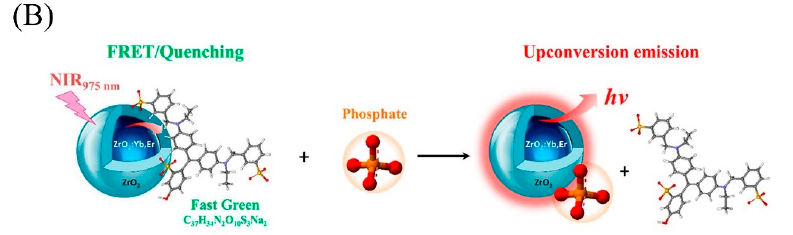
Figure 5. UCNPs for detecting heavy metal, inorganic acid ion and air pollutants. ( A ) (a) Upconver- sion emission spectra of the LiYF 4 : Yb 3+ /Ho 3+ /Ce 3+ (20/2/x mol%) @LiYF 4 as a function of Ce 3+ content in the core. The spectra were normalized by the Ho 3+ emission intensity at 540 nm. The inset is the corresponding luminescence photographs. (b) Typical luminescence photos of the UCNPs-CRD probe solution under the excitation of 980 nm laser (15 W cm − 2 ) at different concentrations of Cr 3+ . ( B ) Schematic illustration of the phosphate determination method based on FRET from ZrO 2 : Yb, Er@ZrO 2 core@shell nanoparticles to the FG acceptor. Reprinted with permission from [104,109].